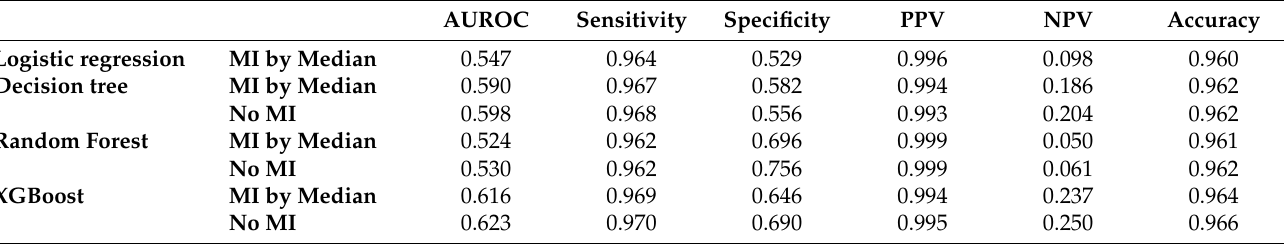
Table 2. Performance parameters of diabetes prediction models. AUROC Sensitivity Specificity PPV NPV Accuracy